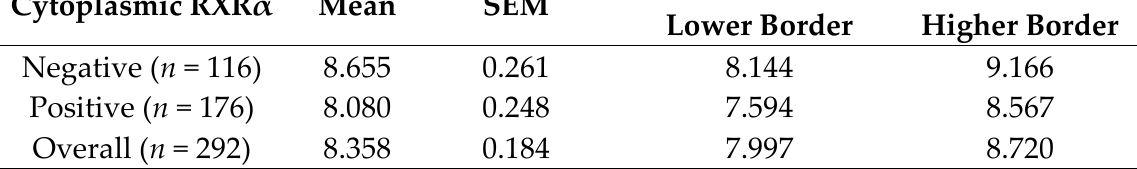
Figure 4. Kaplan–Meier survival analysis of cytoplasmic RXR α positive and negative expression in relation to OS. Statistical significance is shown as p -value determined using the log-rank-test ( p < 0.05). The risk table demonstrates the mean survival time, SEM and 95% confidence interval (CI) for univariate analyses. Table 4. Multivariate Cox regression analysis of cytoplasmic RXR α expression in relation to OS. Variable